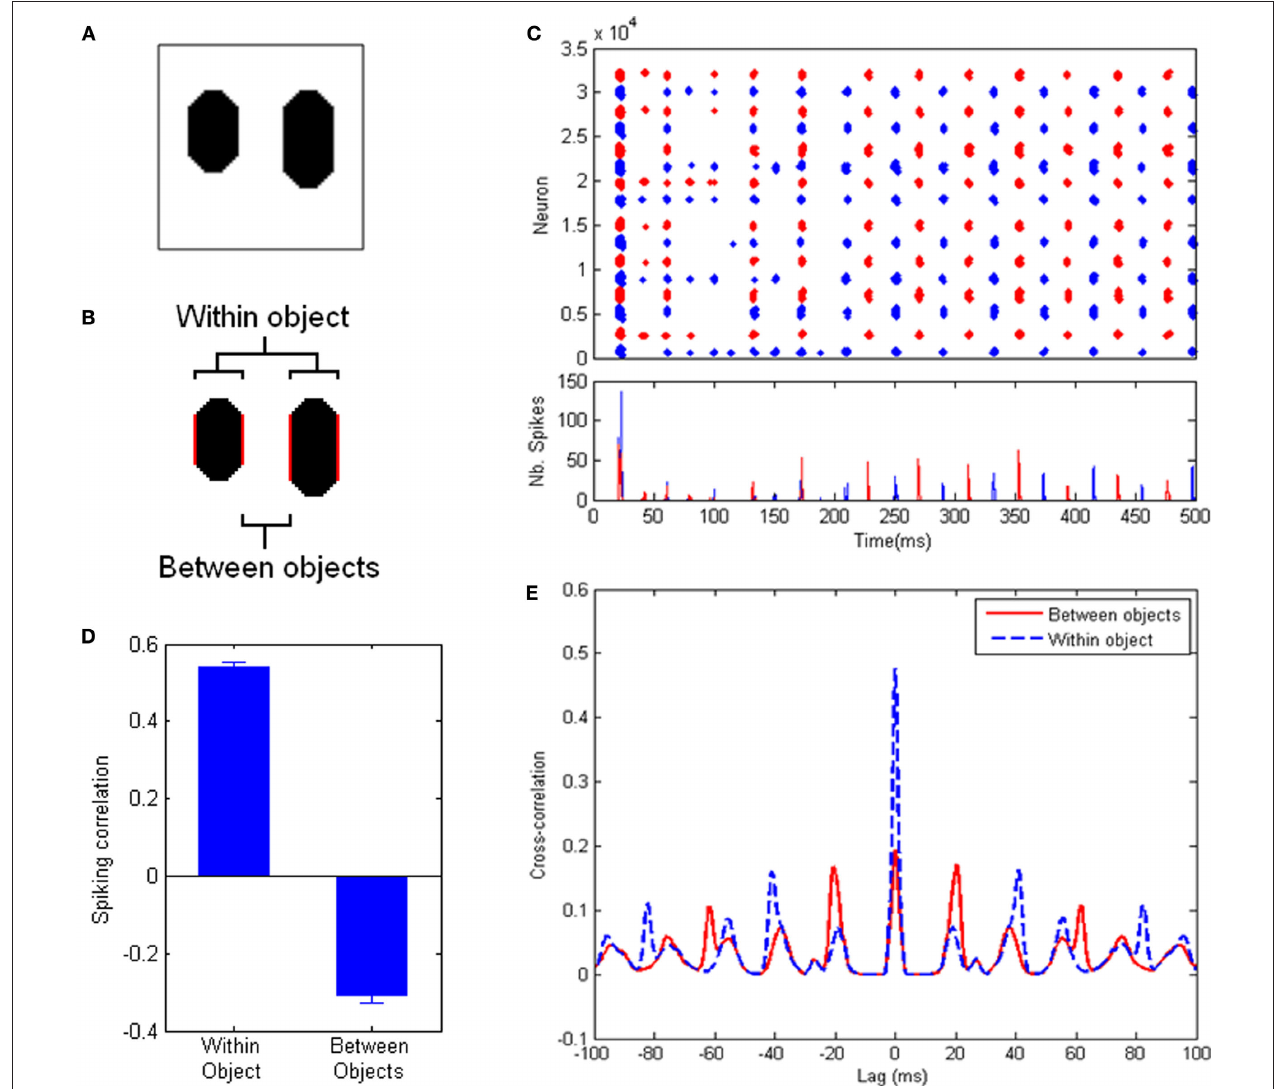
Figure 2 | experiments with a simple test picture. (A) The simple picture used for these experiments: two oblong objects with identical luminance, but different lengths, on a uniform background. (B) The reference populations used for measurements, highlighted in red. Between-objects values consider the inner edges of both objects; within-object values are obtained between the edges of each object, and the two resulting values are averaged. All measurements involve the same distance between populations. (C) (Top) Spike trains of all neurons in the system for an example run. (Bottom) Spike histogram of the same run. Neurons covering the left (resp. right) half of the image are shown in blue (resp. red). After an initial period, an oscillatory regime sets in (at ∼ 50 Hz frequency), with clear alternation between the populations.